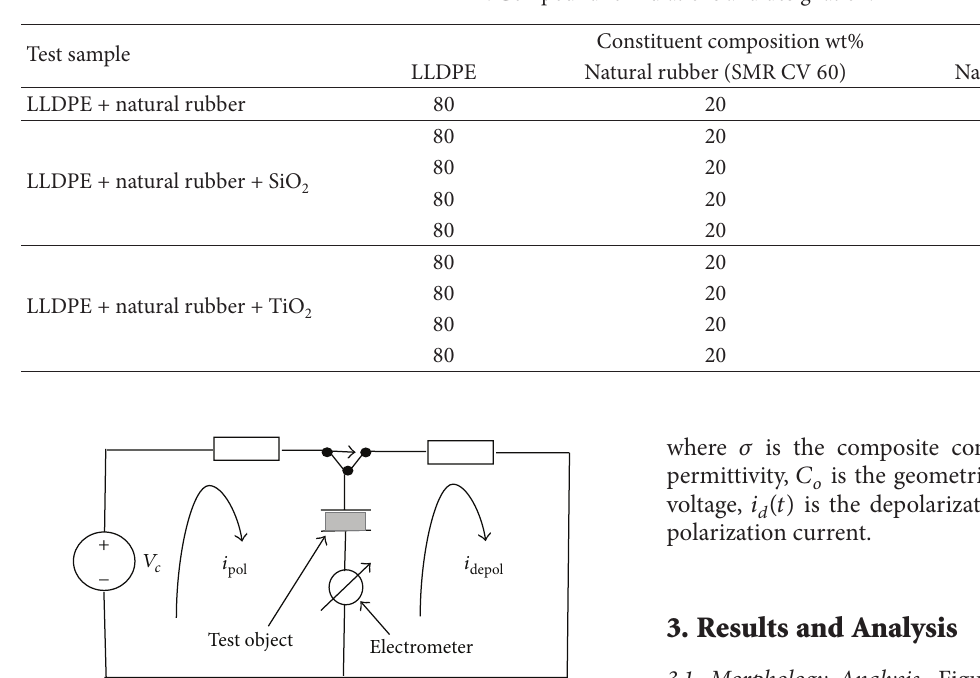
Table 2: Compound formulations and designation.